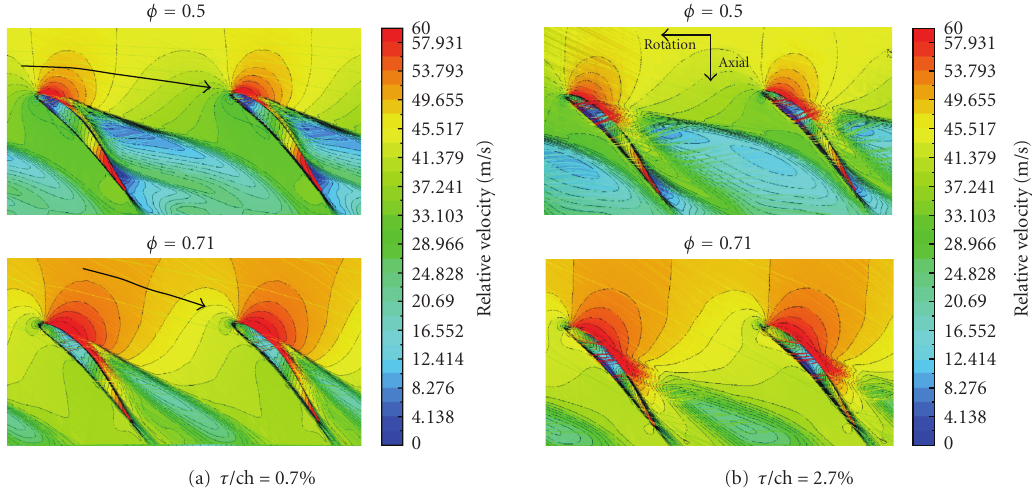
Figure 7: Flow scenario for UNS rotor near the tip showing leakage flow, blockage with leakage vortex, and wake e ff ect.